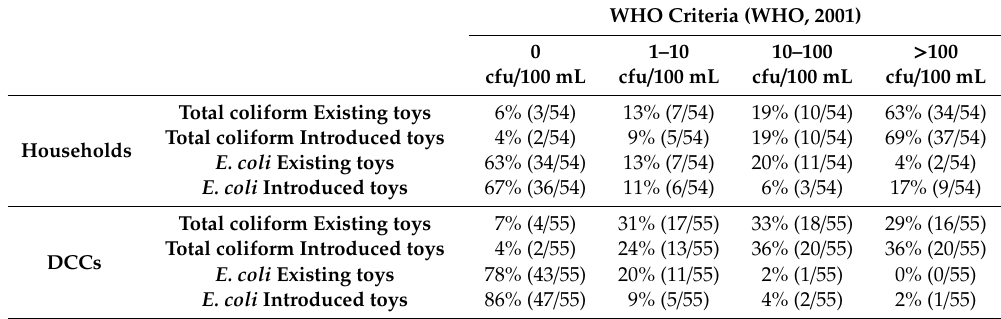
Table 5. Frequency of total coliform and E. coli (counts / 100 mL) on existing and introduced toys in rural households (HHs) and day care centres (DCCs) *.